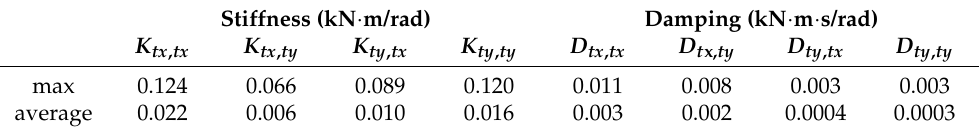
Table 1. Finite difference